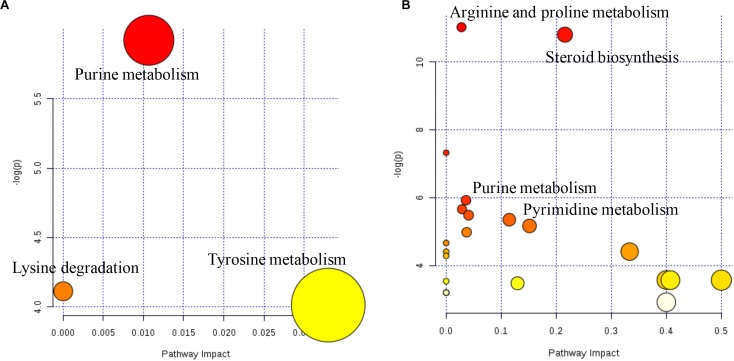
Ruminal metabolomics pathway analysis on the steers with the saponins treated compare to the non-saponins treated diet according to Bos taurus kyoto encyclopedia of genes and genomes pathway database alfalfa hay group (A), soybean hull group (B).